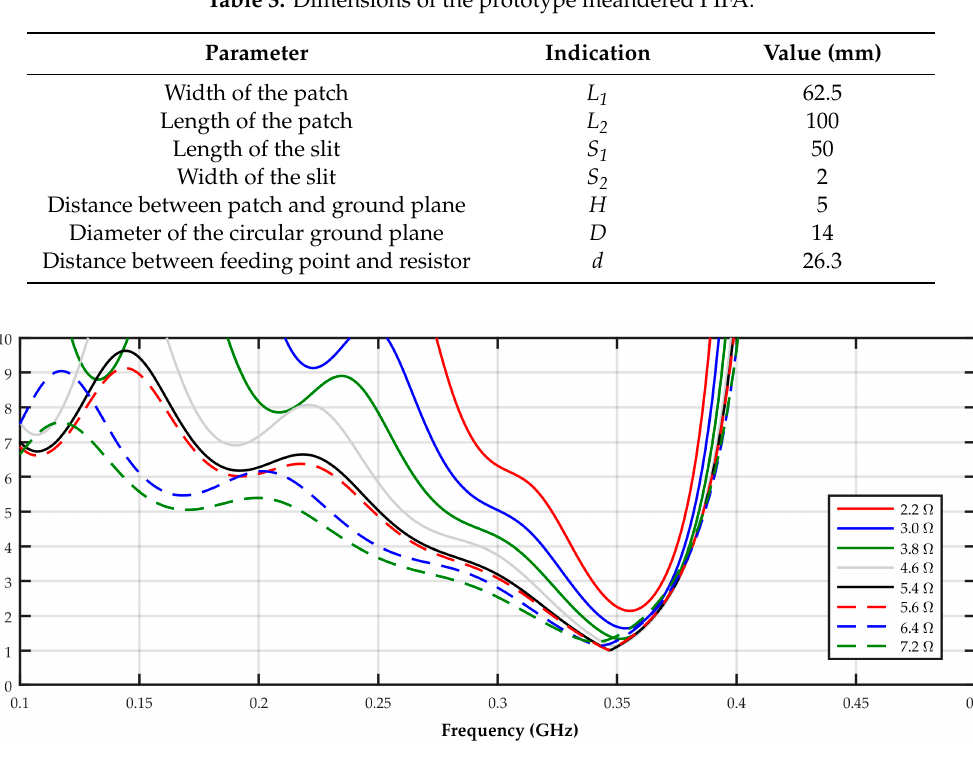
Table 3. Dimensions of the prototype meandered PIFA.